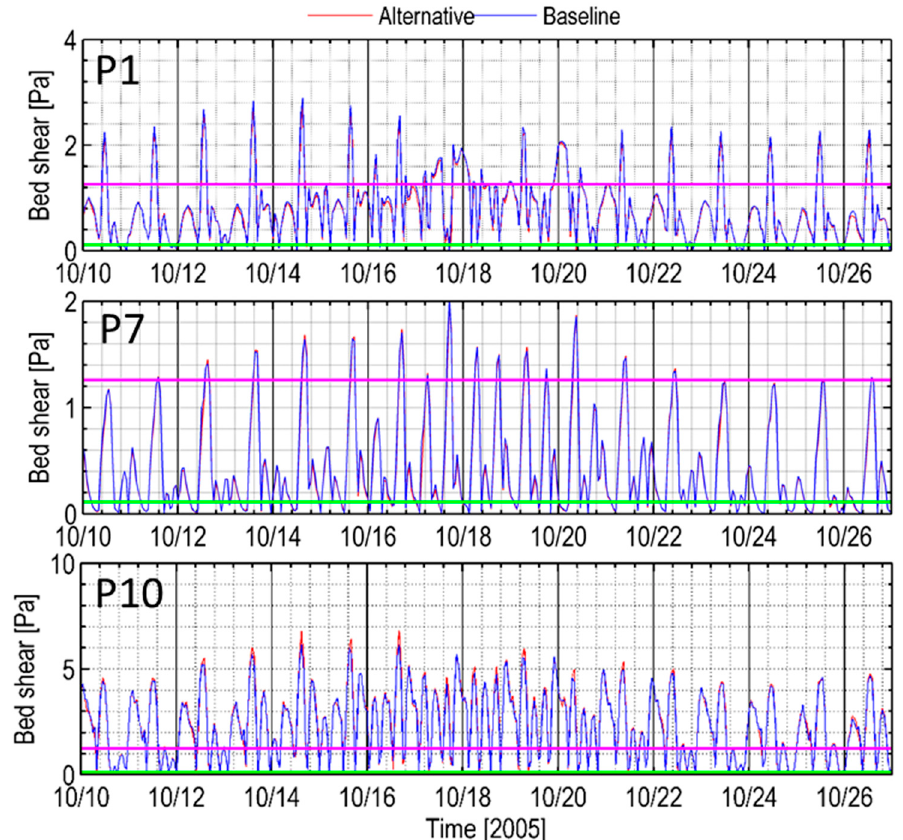
Figure 14. Preferred vs. baseline scenarios: time series of bed shear stress at stations P1, P7, and P10 for typical estuarine conditions (October 2005). Critical bed shear for erosion of sand (0.11 Pa) and gravel (1.26 Pa) are marked as green and pink lines.